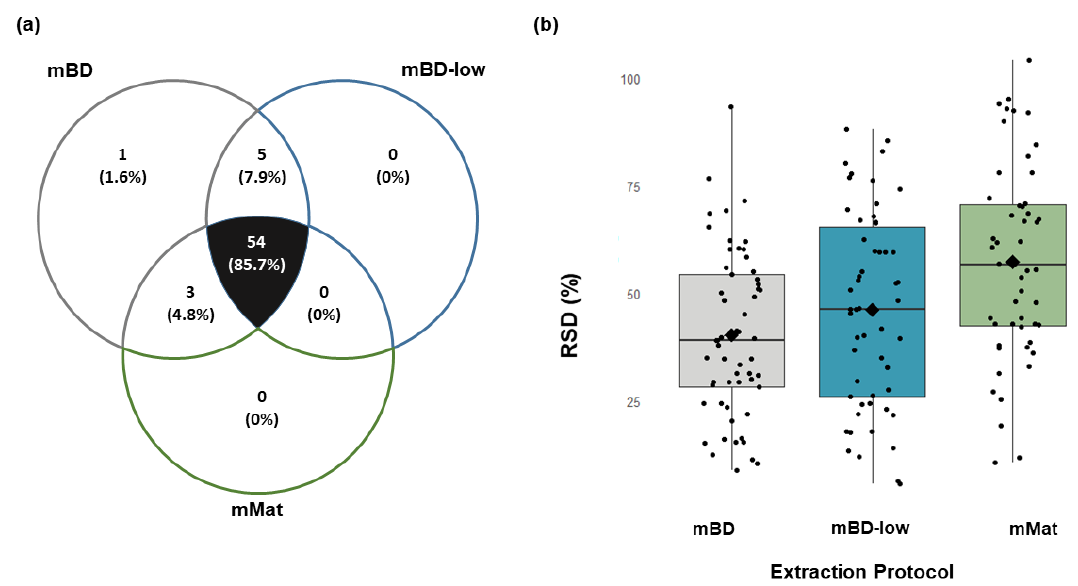
Figure 3. Influence of the different extraction solvents in mouse muscle tissue. ( a ) Venn diagram with principal central carbon metabolites detected (and relative percentages) between the three extraction methods, i.e., modified Bligh–Dyer (mBD), modified Bligh–Dyer with low chloroform (mBD-low), and modified Matyash (mMat). ( b ) Distribution of individual metabolites’ relative standard deviations (RSD) for the different extraction methods. Each black point represents an RSD for a single metabolite. The 54 metabolites common to all three methods are shown here, and the median relative standard deviation (mRSD) is represented by the black middle line of the